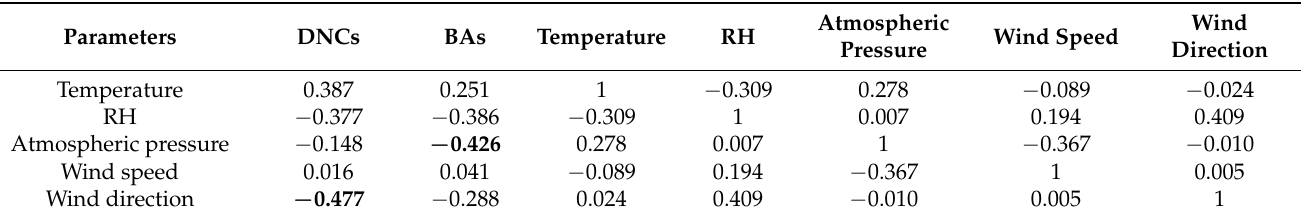
Table 3. Correlation matrix for SARS-CoV-2 daily new cases (DNCs), bacterial aerosol (BA) concen- trations, and meteorological conditions during March 2021.